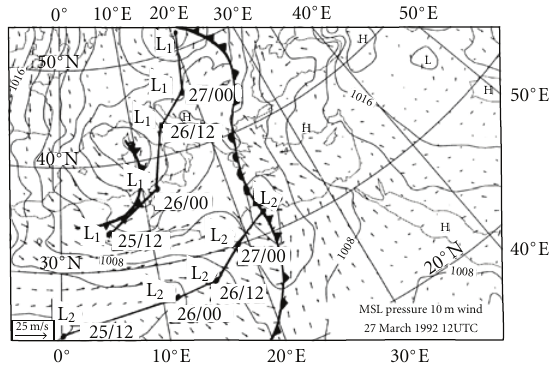
Figure 5: Same as Figure 1, but for 27 March 1992/12:00 UTC. Dots and straight segments show the successive 12-hour positions and tracks of the surface depressions L 1 and L 2 . The numbers dd/hh denote day and hour.